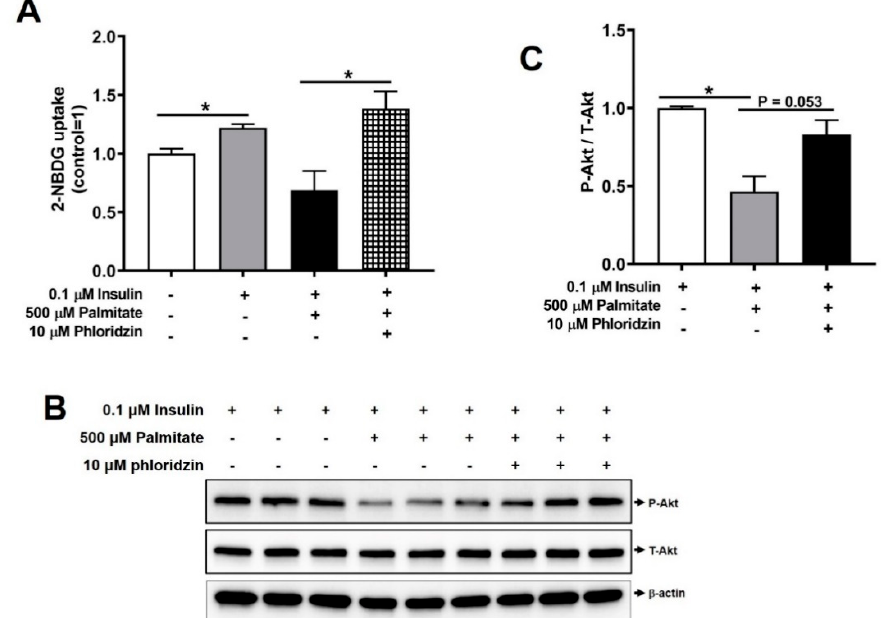
Figure 6. Phloridzin attenuates palmitate-induced insulin resistance in C2C12 muscle cells. ( A , B ) Differentiated C2C12 muscle cells were treated with 10 µ M phloridzin or 500 µ M palmitate for 48 h and then incubated with and without 0.1 µ M insulin for 30 min. Cells were analyzed by glucose uptake ( A ) or Western blotting ( B ). ( C ) Quantification of phospho-Akt/total-Akt using the ATTO image analysis software. All experiments were independently repeated at 3 times. Results are expressed as mean ± SEM. Data were analyzed using two-tailed unpaired t -test. * p < 0.05 compared to the control